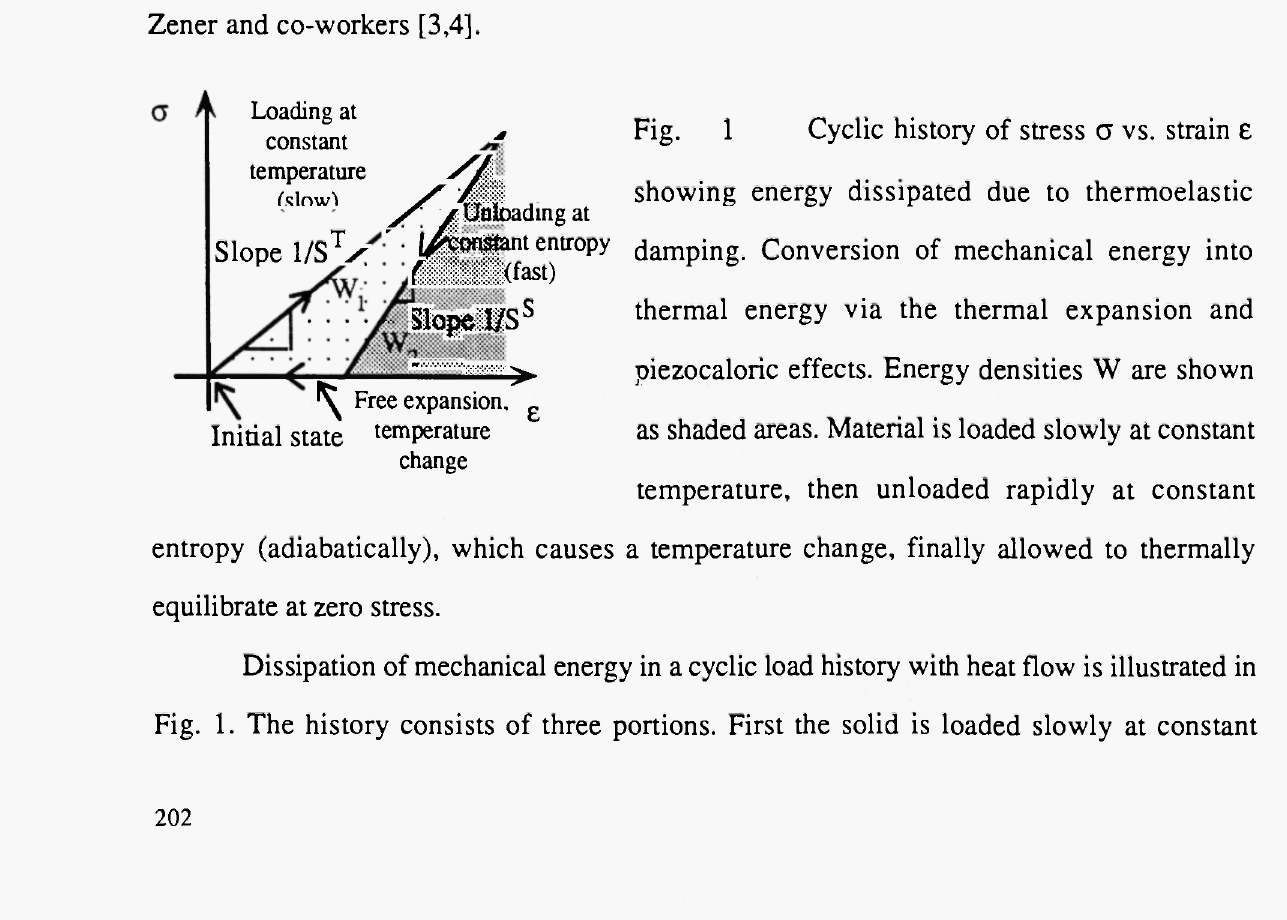
piezocaloric effects. Energy densities W are shown as shaded areas. Material is loaded slowly at constant change temperature, then unloaded rapidly at